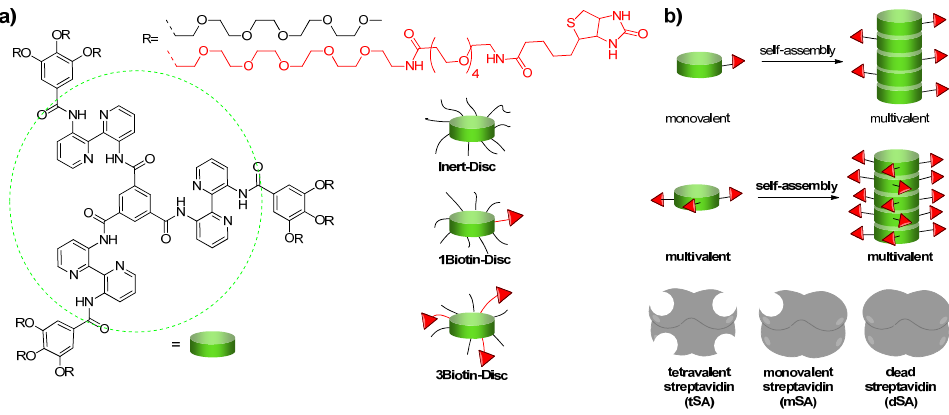
Figure 1. ( a ) Library of non- and biotinylated discotics; ( b ) Self-assembling multivalency of the discotics and the streptavidin mutants used in this